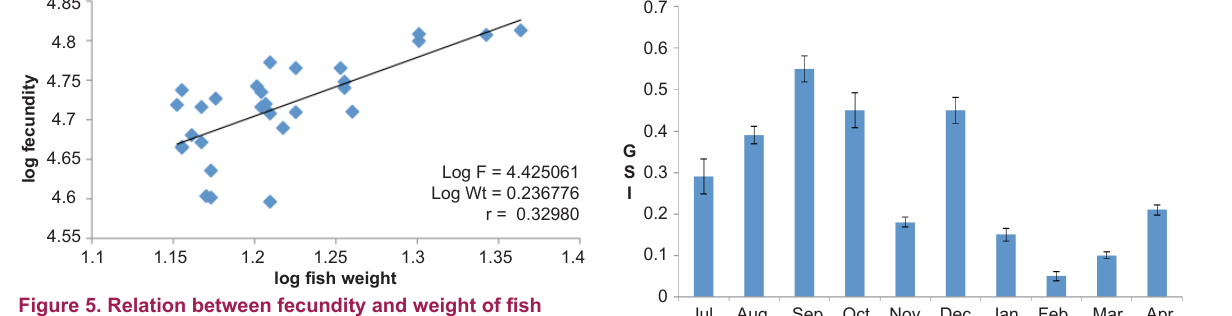
Figure 5. Relation between fecundity and weight of fish